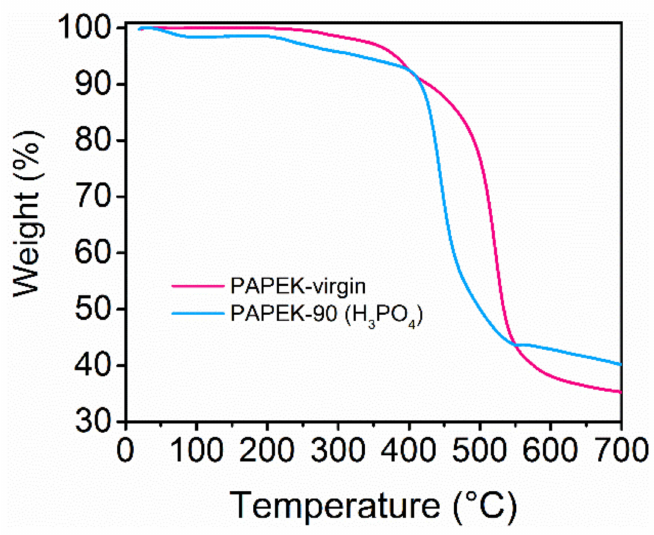
Figure 2. TGA of PAPEK-virgin and PAPEK-90 membrane (H 3 PO 4